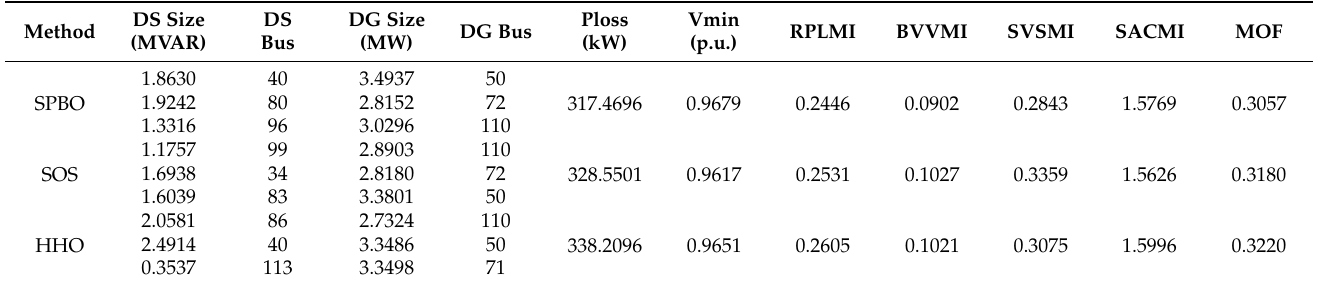
Table 12. Comparison of results for simultaneous DS and GT-DG allocation (case-6) for 118-bus test